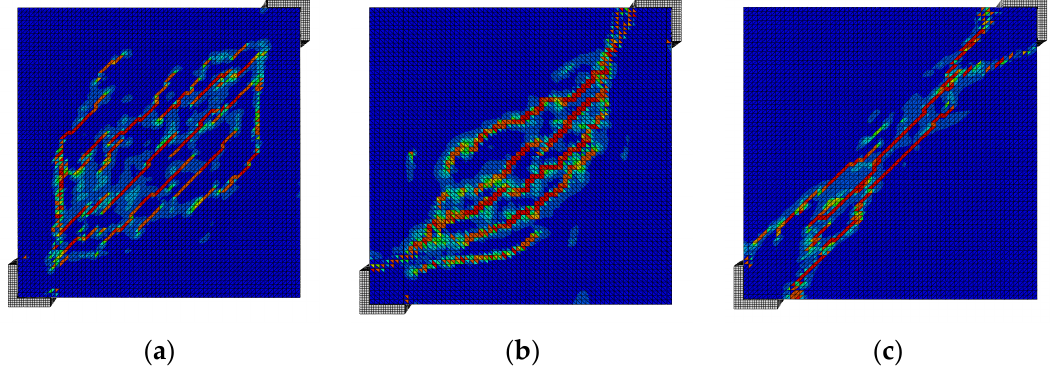
Figure 30. Tensile damage pattern at the peak load for different plaster thicknesses: ( a ) 20 mm; ( b ) 30 mm; ( c ) 50 mm.